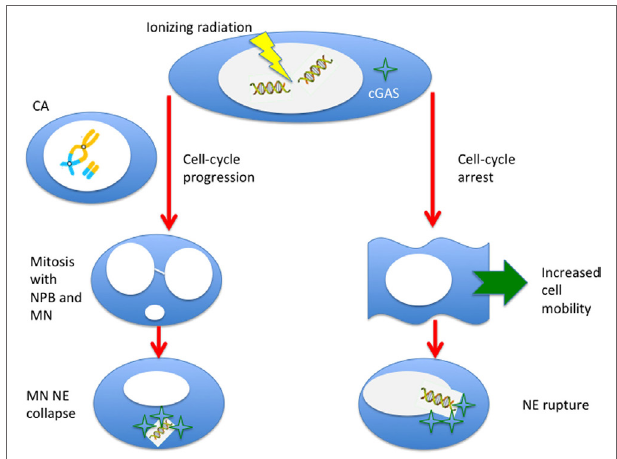
FiGURe 6 | Ionizing radiation can induce cytosolic DNA, thus triggering the cyclic GMP–AMP synthase (cGAS)/stimulator of interferon genes (STING) pathway, in two different ways. If cells progress to mitosis carrying chromosome aberrations, MN (from acentric fragments) can be produced at the first mitosis along with nucleoplasmic bridges (NPB, from dicentrics). These micronuclei can be incorporated in the cytoplasm of the daughter cells and, following the collapse of the nuclear envelope (NE), can be sensed by the cGAS. Alternatively, even if the cell is blocked or delayed in the cell-cycle, radiation-induced DNA fragments can leak through a damaged NE. This effect can be more likely for very small fragments induced by densely ionizing radiation, and NE rupture can be triggered by the enhanced mobility of the cells following radiation